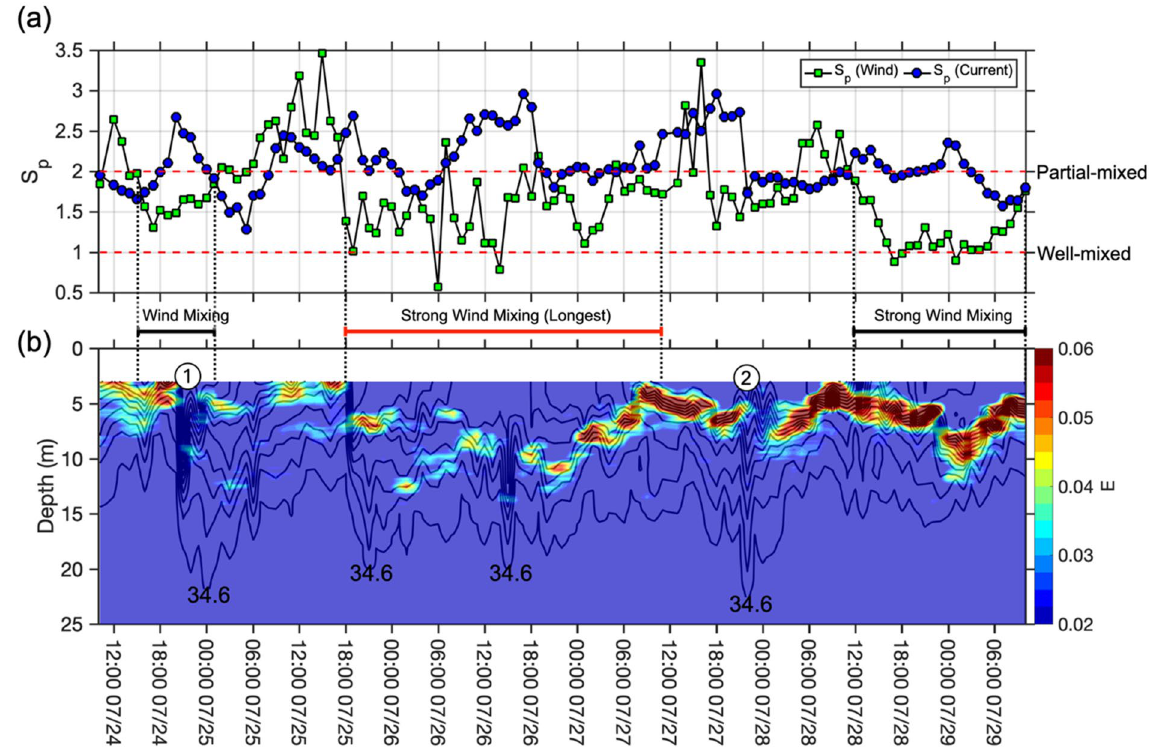
Figure 4. The temporal variability of stratification parameters at ZHJ2. ( a ) The S p induced by wind (green squares) and current (blue circles). The red dashed lines indicate S p equals to 1 and 2, which stand for the threshold of well-mixed and partial mixing in the water column. The black and red bars below the S p graph mark the periods of strong wind mixing. ( b ) The color contours of the static stability index, E, at ZHJ2. Salinity contours (black lines) are superimposed. Circled numbers indicate the examples of the NIWs described in the text and in following